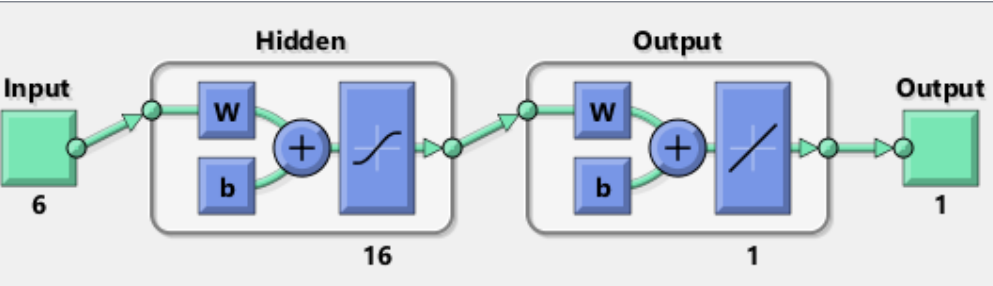
Figure 4. Proposed network architecture with functions.